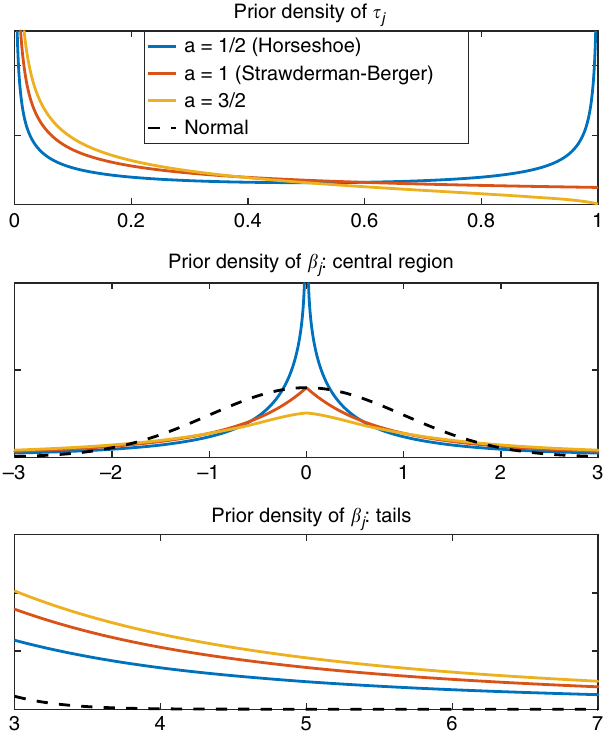
Fig. 3 Densities of the priors. Upper panel: Density of the three-parameter beta prior on the shrinkage factor τ j with ϕ = 1, b = 1/2, and three different a values. Middle panel: Central region of the marginal prior density on the effect size β j with ϕ = 1, b = 1/2, and three different a values, in comparison with the standard normal density. Lower panel: Tails of the marginal prior density on the effect size β j with ϕ = 1, b = 1/2, and three different a values, in comparison with the standard normal